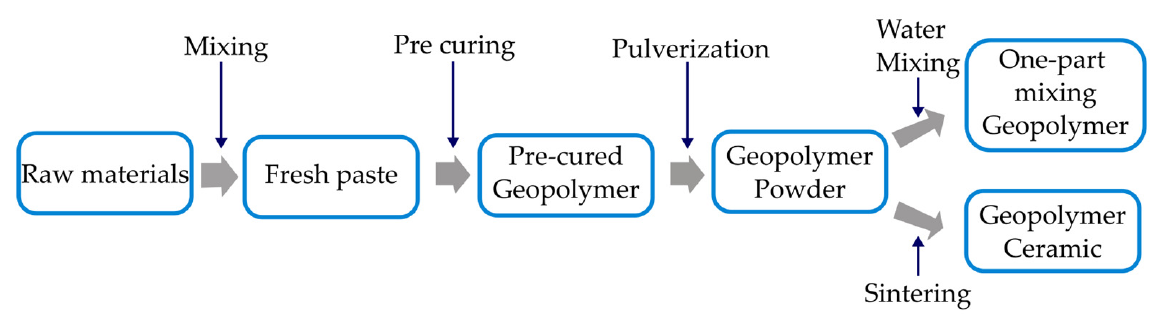
Figure 2. Preparation procedure for SCWS (SiC whiskers)/KGP (Kaolin Geopolymer) composite [46].